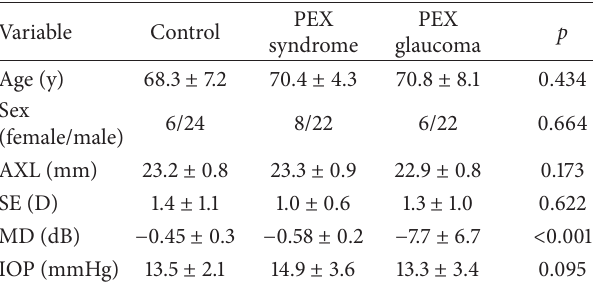
Table 1: Demographic and clinical characteristics of patients by